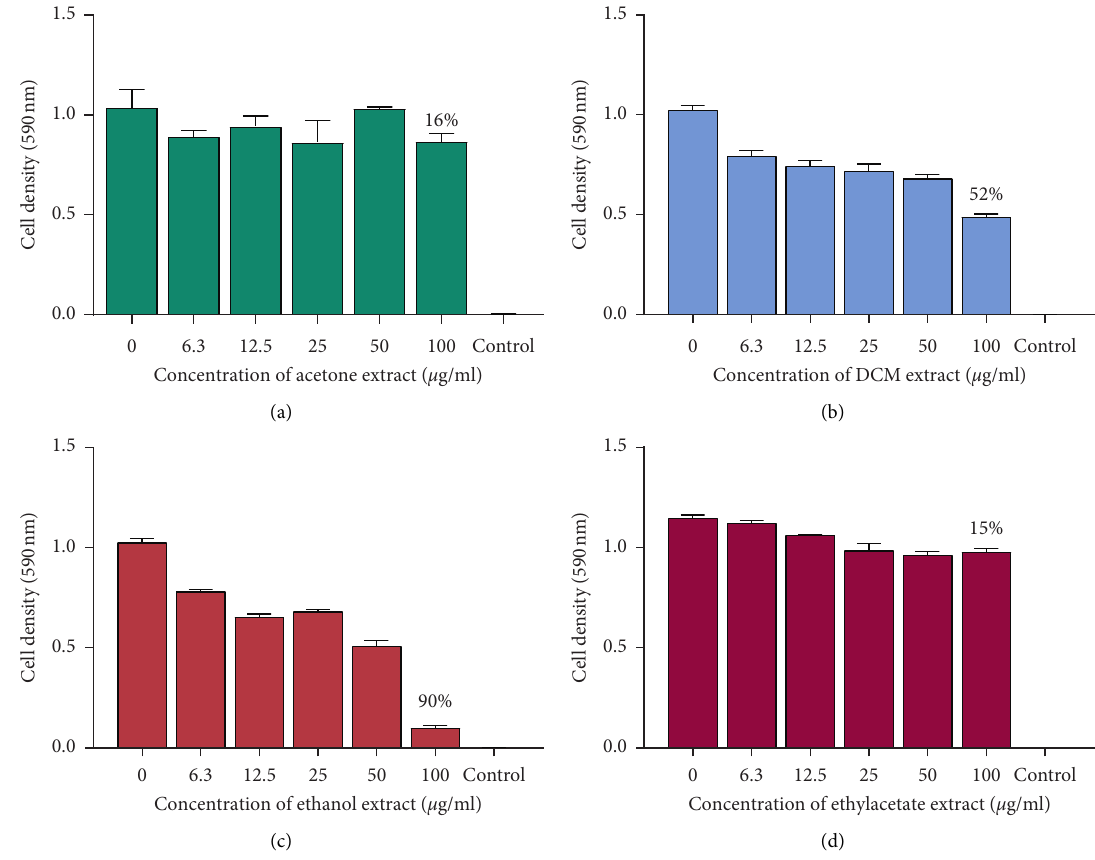
Figure 6: The effects of extracts of pods of P. thonningii against C. krusei : (a) effect of acetone extract, (b) effect of DCM extract, (c) effect of the ethanol extract, and (d) effect of ethyl acetate extract. Concentrations of extract ranged from 6.3 μ g/mL to 100 μ g/mL. Values are in mean cell density at 590nm wavelength ± the standard deviation. N �